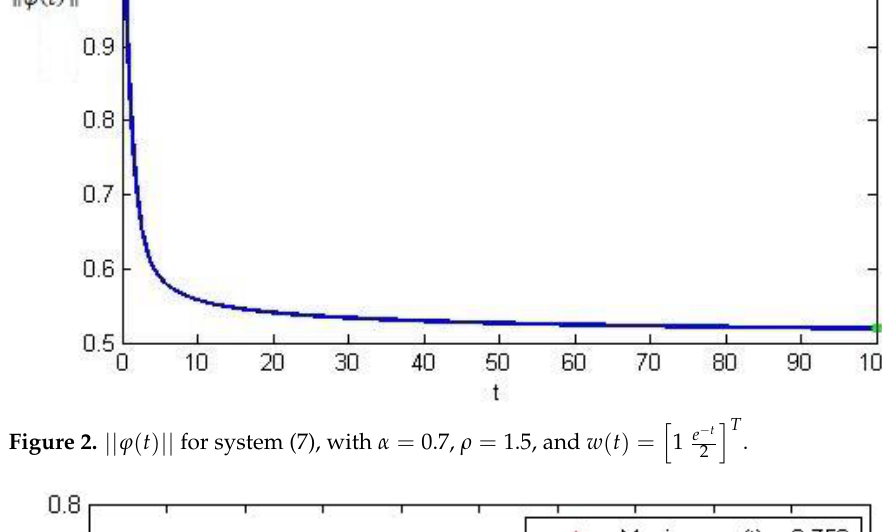
−𝑡 ] 𝑇 . 2 (cid:104) (cid:105) T 1 e − t . −𝑡 2 ] 𝑇 . 2